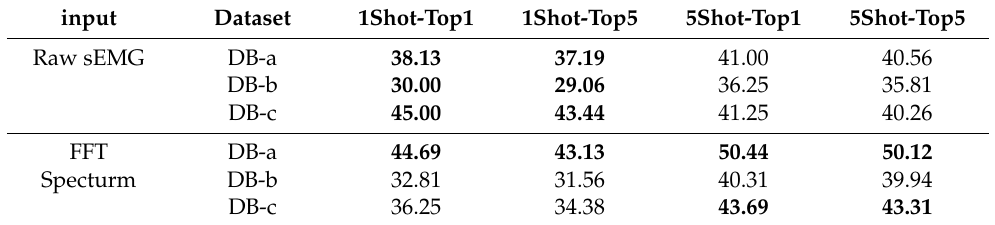
Table 7. 5-way 1-shot and 5-way 5-shot classification top 1 and top 5 accuracy (%) of different input forms for new subject on CapgMyo with MAML. The meta batch size is set to 64. The boldface numbers represent the best classification accuracies for each input and dataset compared with Table